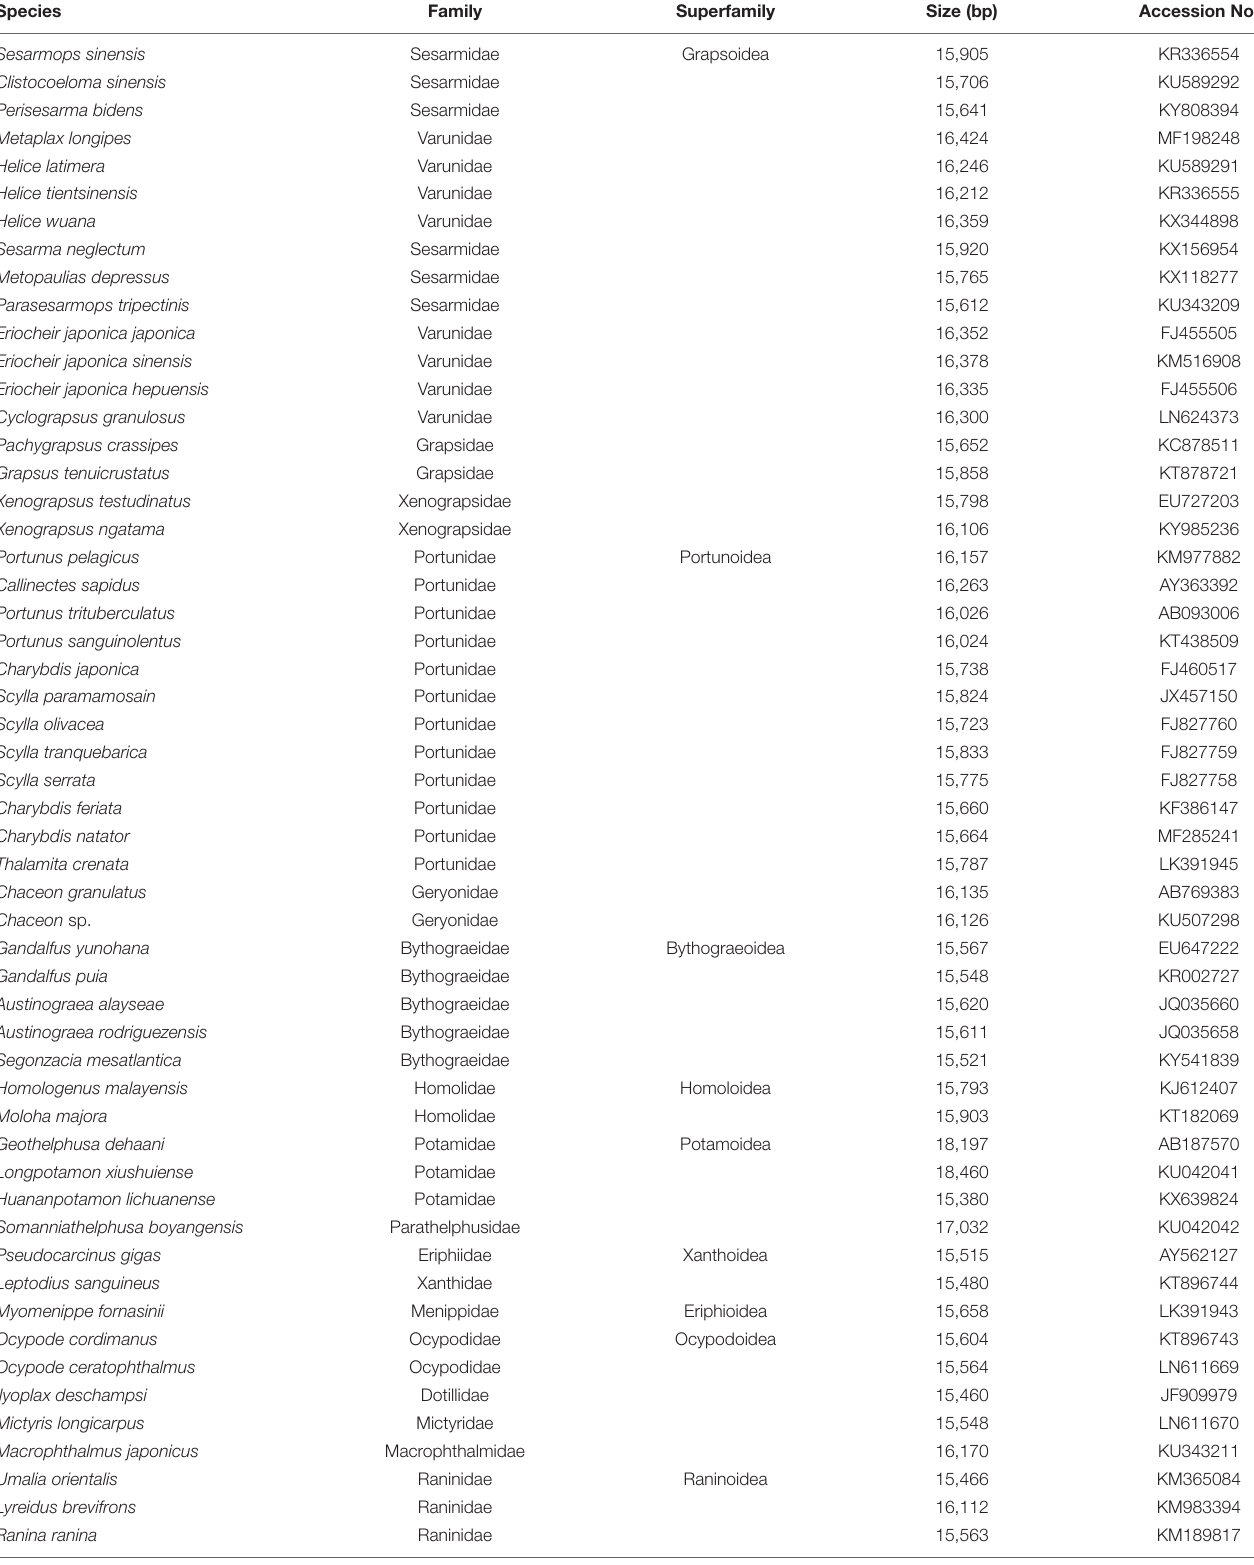
TABLE 1 | List of brachyuran species with their GenBank accession numbers.